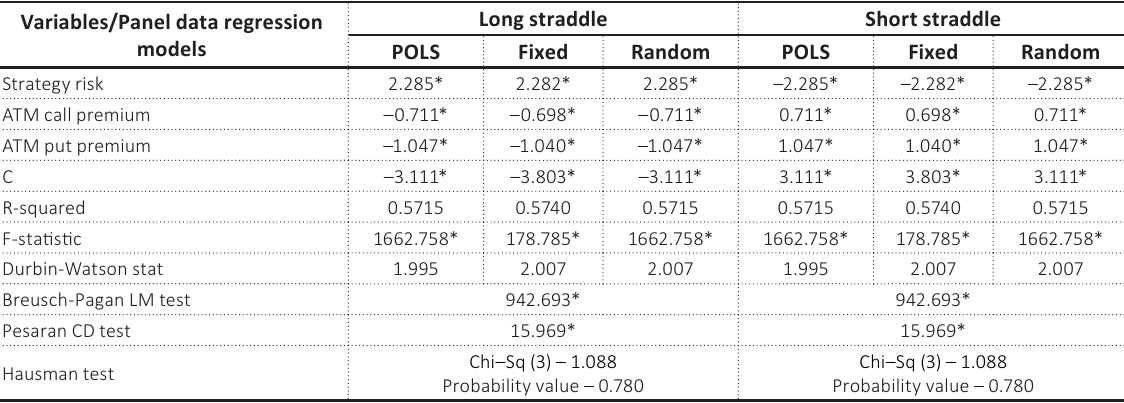
Table 4. Panel regression analysis for long straddle and short straddle strategies Variables/Panel data regression